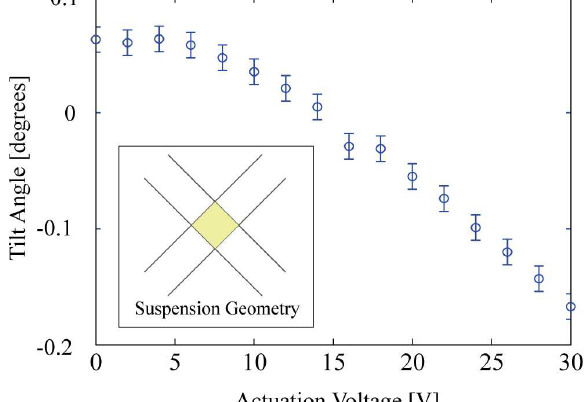
Figure 8: Mirror tilting by applying a potential difference between two opposite comb